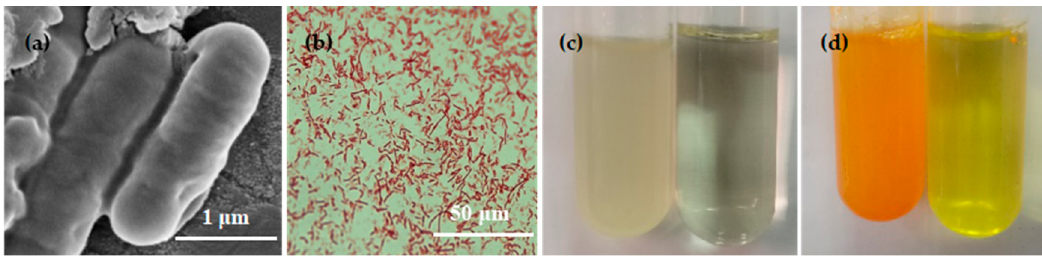
Figure 2. Morphology in SEM view ( a ), Gram staining in a biological microscope view ( b ), and ammonia test ( c and d ). ( c ) before adding the Nessler’s reagent ( d ), after adding the Nessler’s reagent. (left: the experimental group; right: the control group).